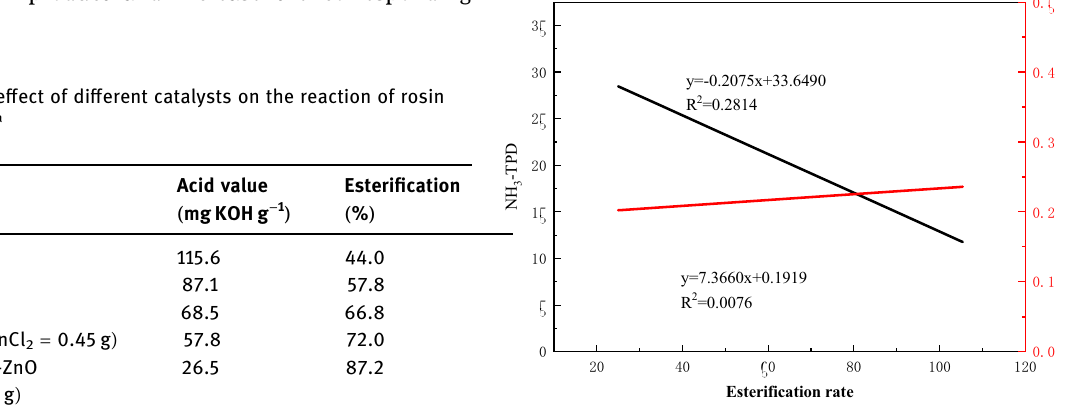
Figure 5: Linear fi t results of the responses to di ff erent zinc